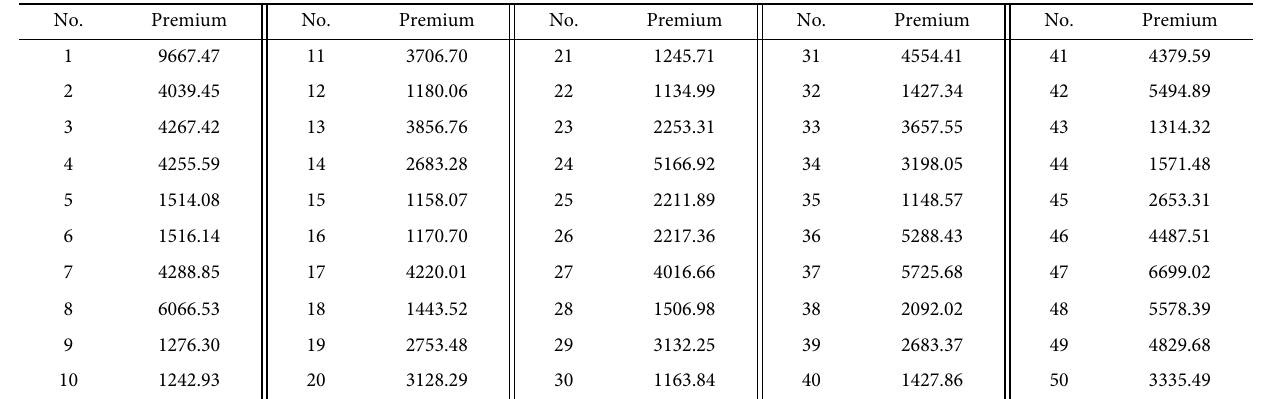
Table 7 Final insurance